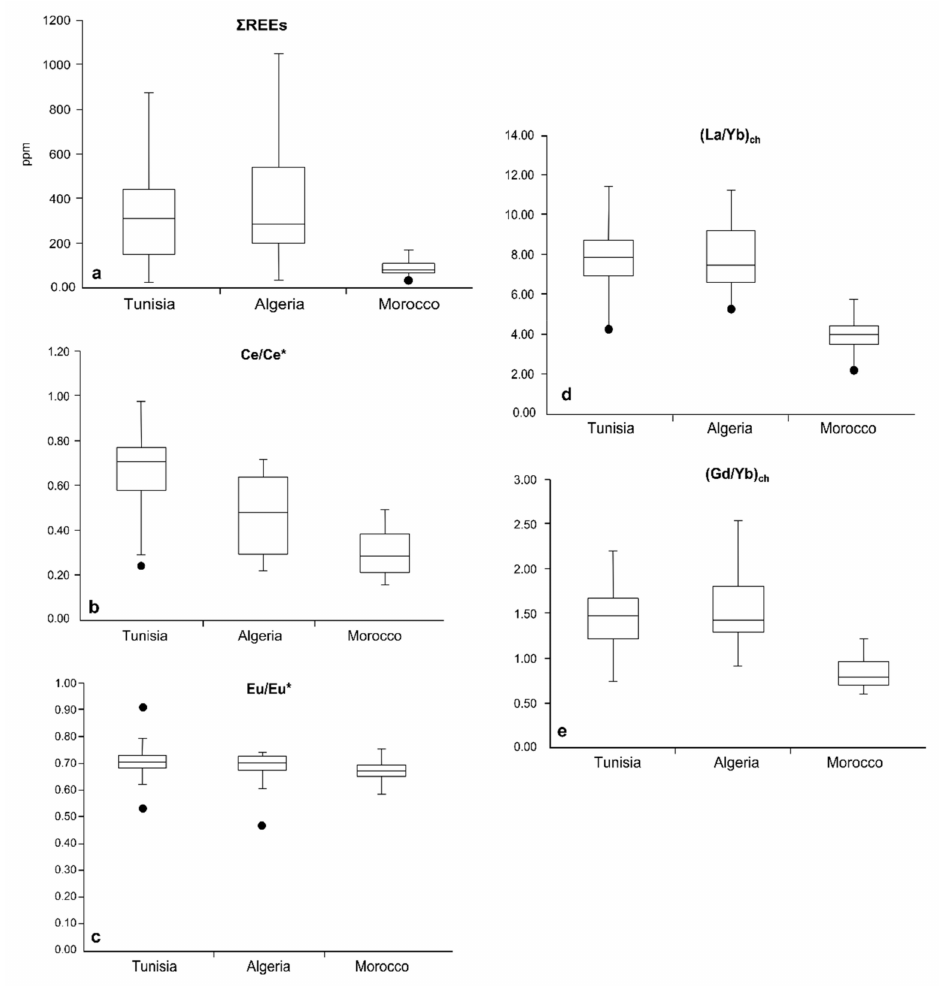
Figure 8. Box and whisker plots of Σ REEs ( a ) and selected geochemical proxies ( b ) Ce/Ce*; ( c ) Eu/Eu*; ( d ) (La/Yb) ch ; ( e ) (Gd/Yb) ch ) calculated for the studied samples grouped by loca- tion. The horizontal bar in the box refers to the median value; the ends of the whiskers are the maximum and minimum values of variables; the top and bottom of the boxes are the values of first and third quartiles; circles represent the outlier values of the